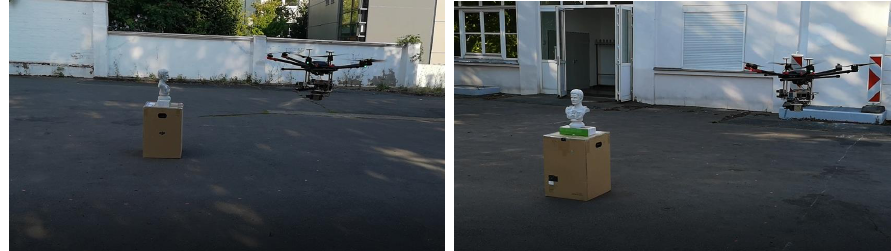
Figure 24. Sample images of the first prototype of our aerial measurement system. So far we have tried simple flight experiments with a hexacopter (DJI Matrice 600 PRO), and several key problems still remain to be solved, such as smooth path planning and electromagnetic interference of